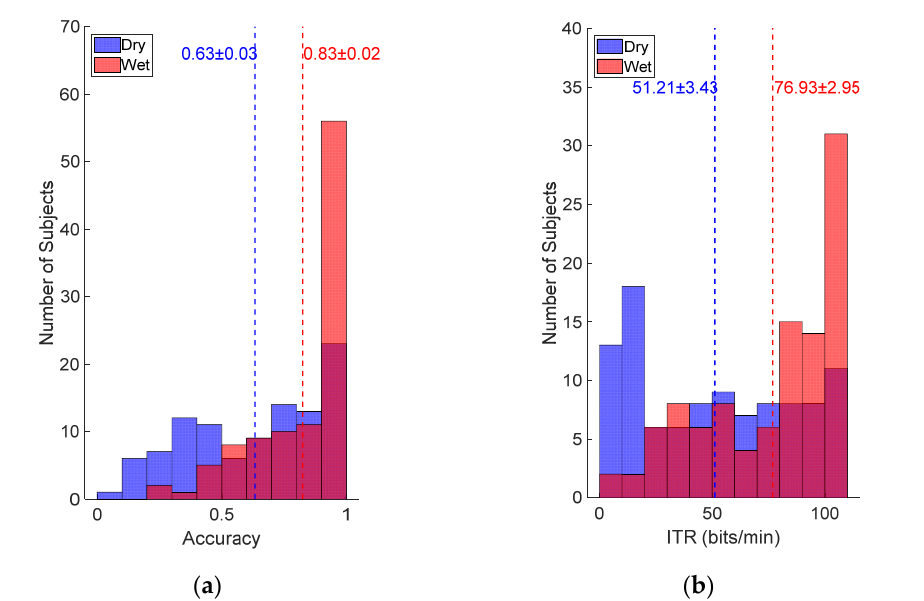
Figure 5. Distribution of number of subjects with regard to ( a ) classification accuracy and ( b ) ITR in the online BCI experiment. The dotted lines represent the average performance of all subjects.